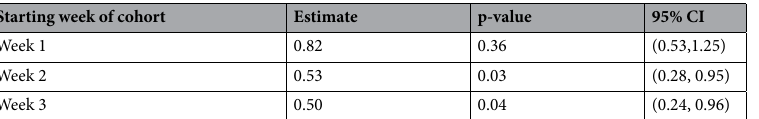
Table 1. Ratio between the incidence rate of each repeatedly tested cohort with respect to the newly enrolled population.